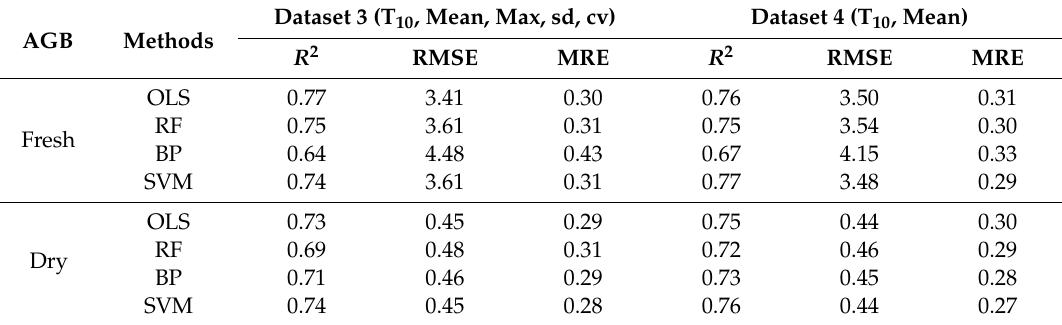
Table 4. R 2 , RMSE, and MRE for linear regression between measured fresh / dry AGB and